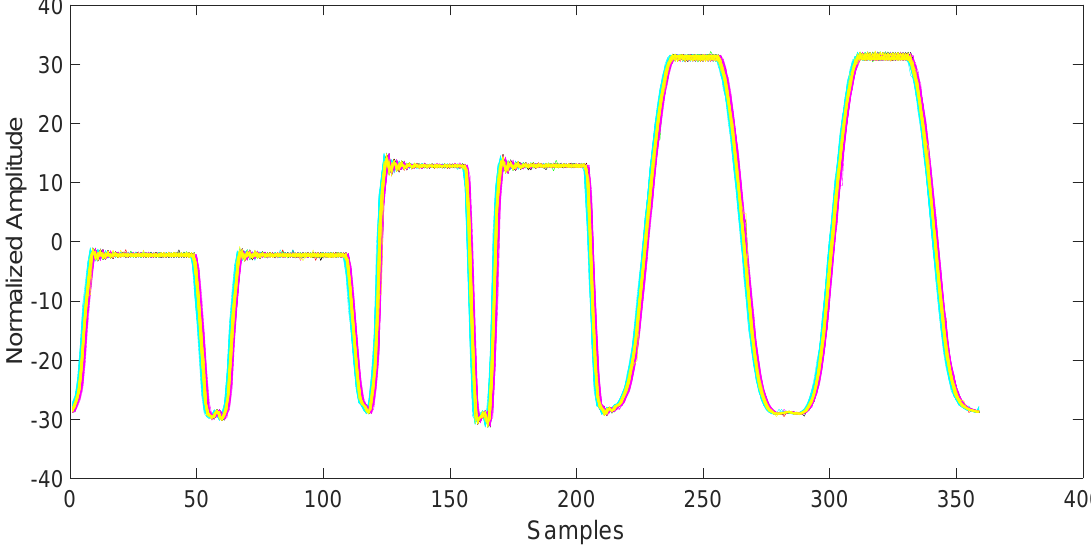
Figure 4. Accelerometers output for all 6 days of data after synchronization and normalization. It has been used for the synchronization of the responses. Each color represents a different